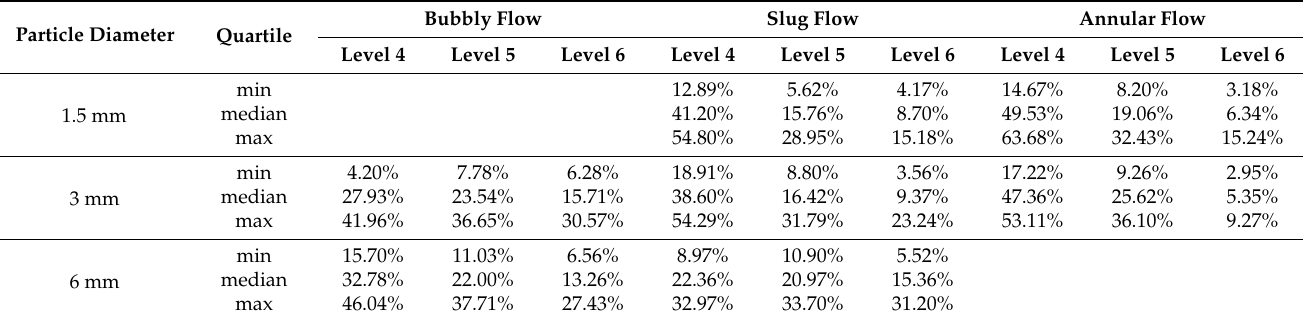
Table 4. Distributions of EMD energy spectrum on levels 4–6.